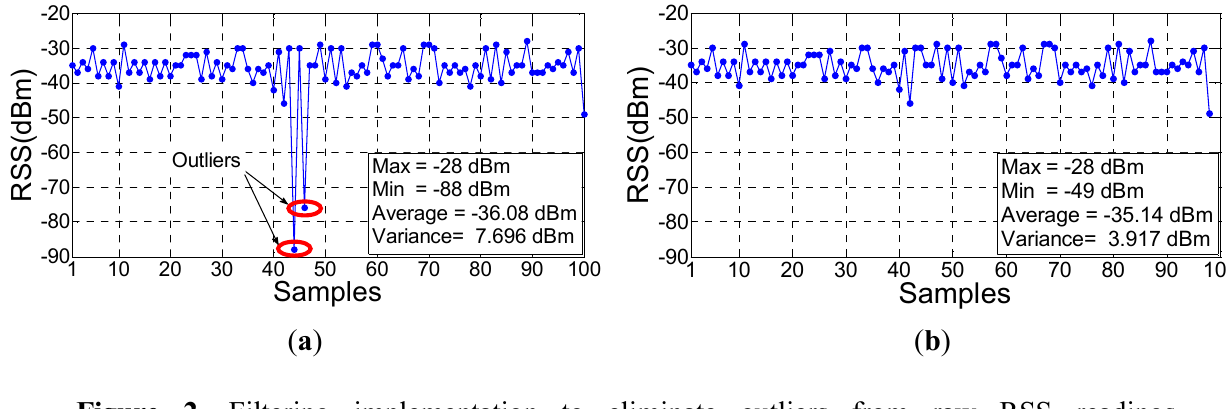
Figure 2. Filtering implementation to eliminate outliers from raw RSS readings (100 samples in the raw RSS readings and 2 of them are eliminated). ( a ) Raw RSS readings; ( b ) Filtered RSS